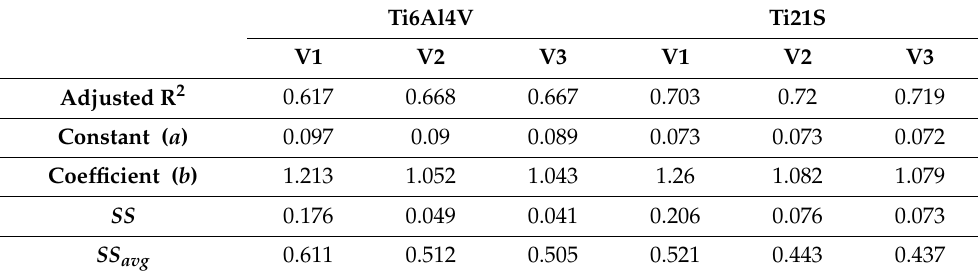
Table 6. Results for